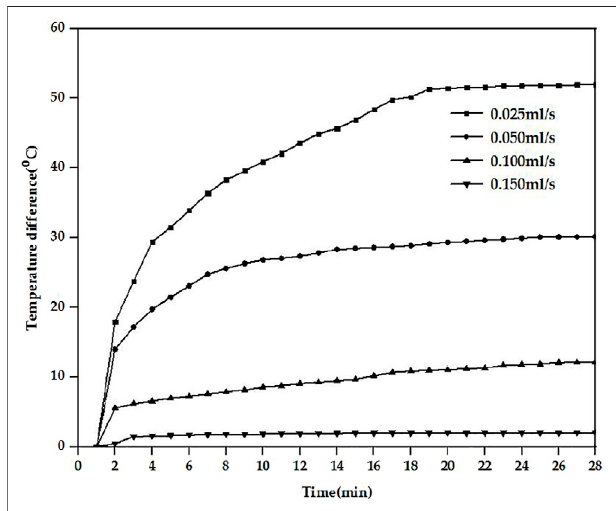
FIGURE 7 | The relationship between different fl ow rates and corresponding temperature